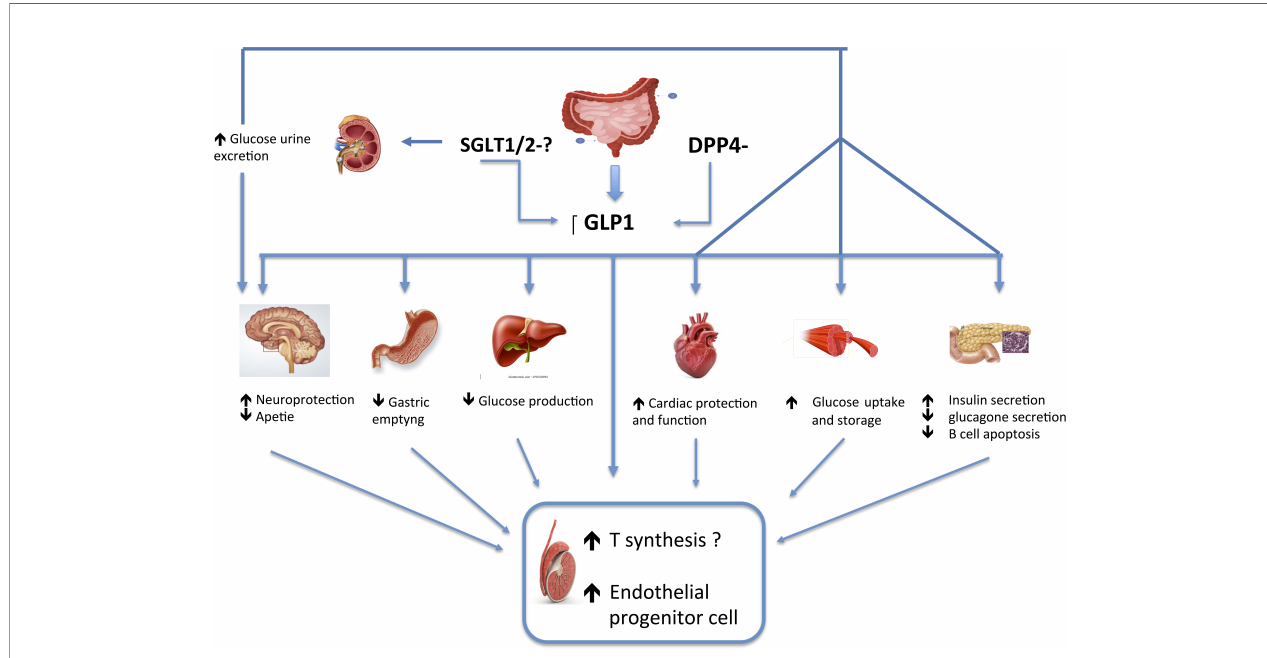
FIGURE 1 | Effects of the new anti-diabetic drugs on male HPG